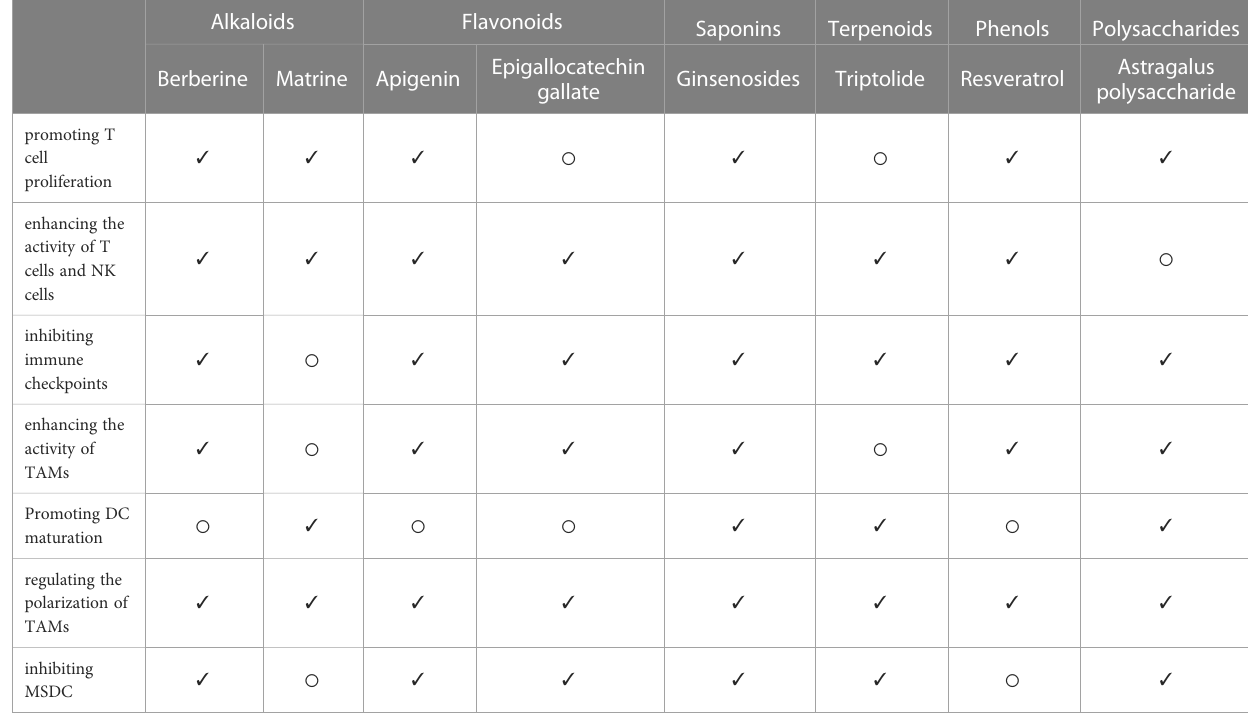
TABLE 1 Mechanism of action of TCM active components in regulating tumor